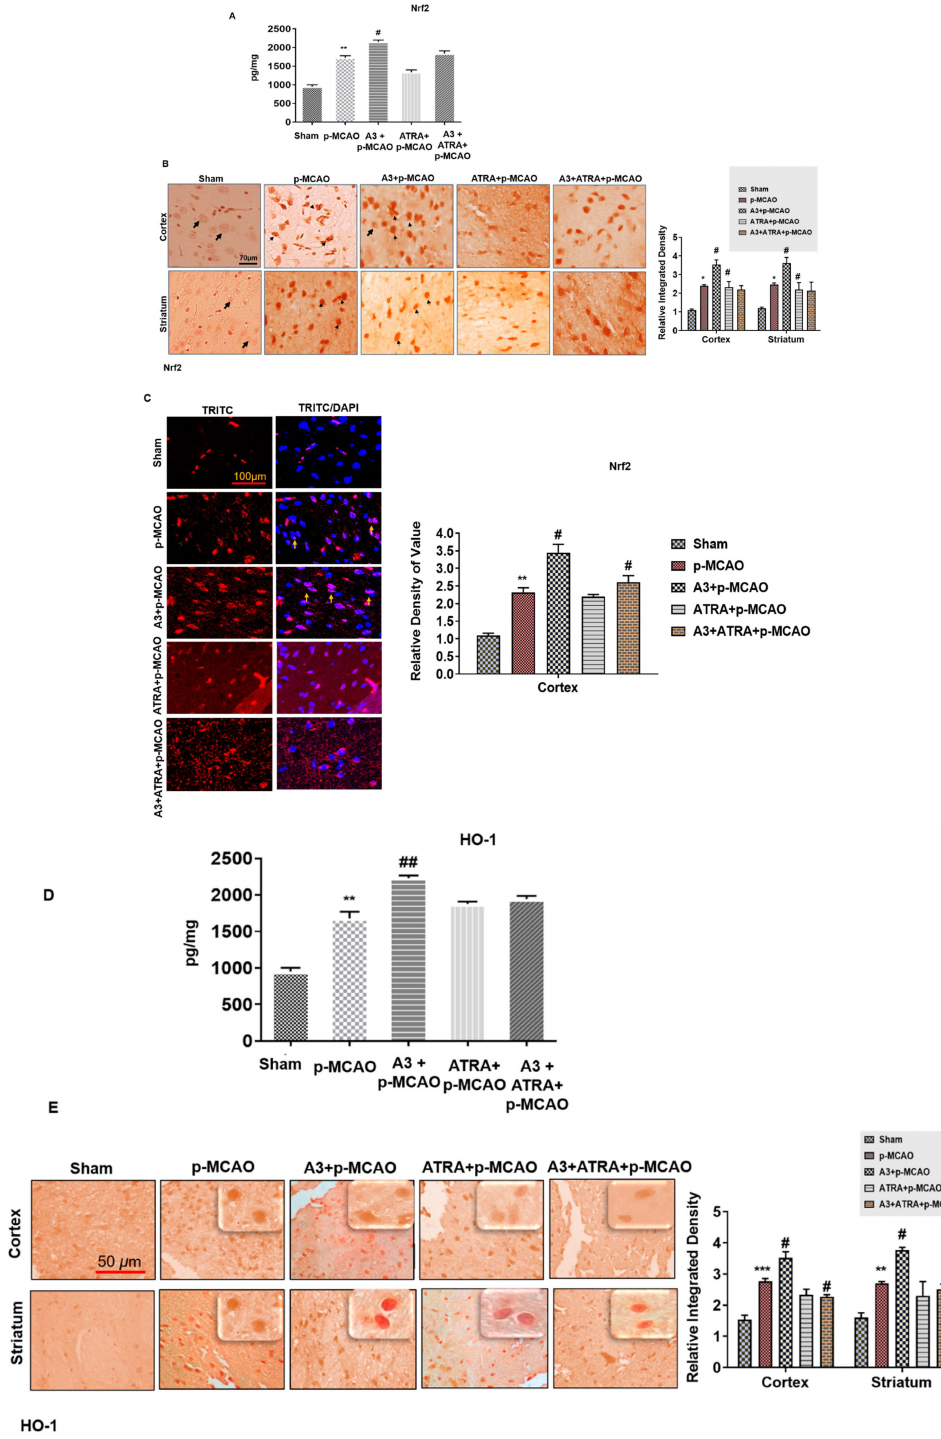
Figure 5. A3 modulates the antioxidant capacity of the brain via the Nrf2 signaling pathway ( A ) The protein expression of Nrf2 was quantified by ELISA in the brain cortex. ** p < 0.01 vs. sham while # p < 0.05 vs. p-MCAO ( B ) Immunohistochemical results for Nrf2 in cortex and striatum tissues of the brain. Bold arrows indicate a clear nucleus, while thin arrowhead shows nuclear staining, indicating Nrf2 translocation to the nucleus. Sham group shows the cytoplasmic localization of Nrf2 protein whereas A3 + p-MCAO treated group demonstrated nuclear localization. Scale bar = 70 µ m, magnification 40 × , ( n = 5 / group). * p < 0.05 vs. sham, # p < 0.05 vs. p-MCAO group. ( C ) Immunofluorescence reactivity of Nrf2 in cortex ( n = 5 / group). The aforementioned data is the representation of 3 numbers of experiments. Scale bar = 100 µ m, magnification 40 × . ** p < 0.01 vs. sham, # p < 0.05 vs. p-MCAO. Nrf2 was tagged